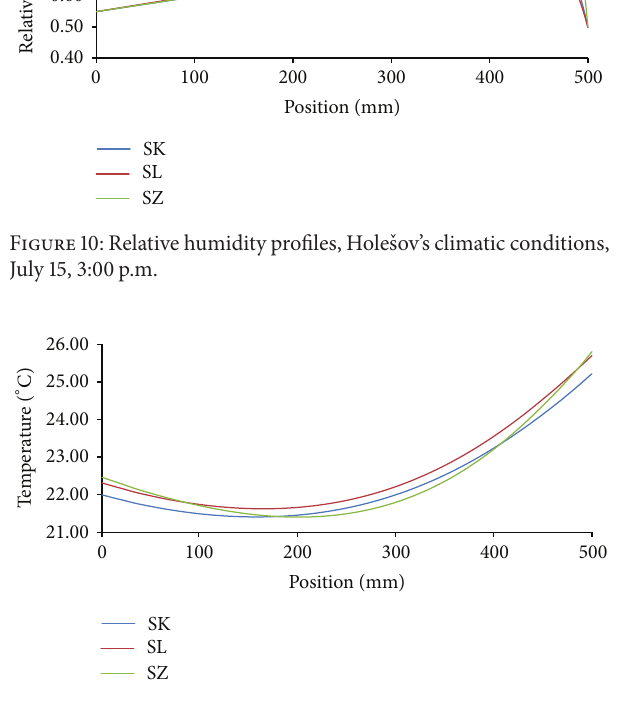
Figure 11: Temperature profiles, Holeˇsov’s climatic conditions, July 15, 3:00 p.m.